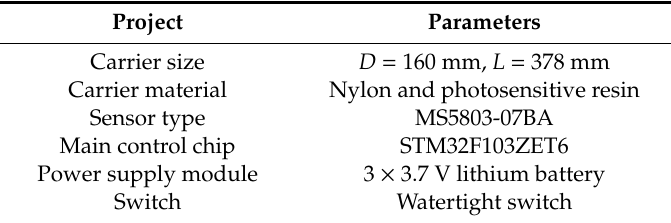
Figure 13. Images of the carrier. Table 2. Specific parameters of the